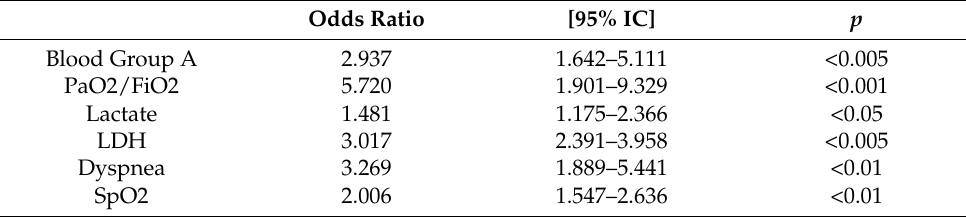
Table 3. Odds ratio and 95% confidence interval for variables significantly associated with ICU admission after multiple logistic regression and correction for sex, age, and comorbidities. Odds Ratio [95% IC]